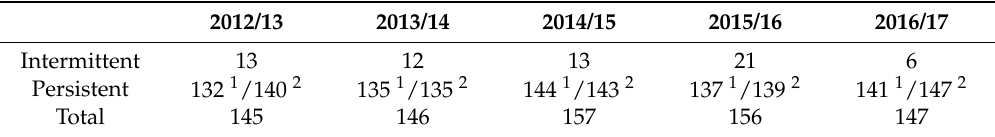
Table 1. Intermittent and persistent snow cover days (SCD) during the observation period. 1 and 2 denote the persistent SCD derived from the combination of albedo and air temperature and below − 1 °C of daily mean surface temperature, respectively.